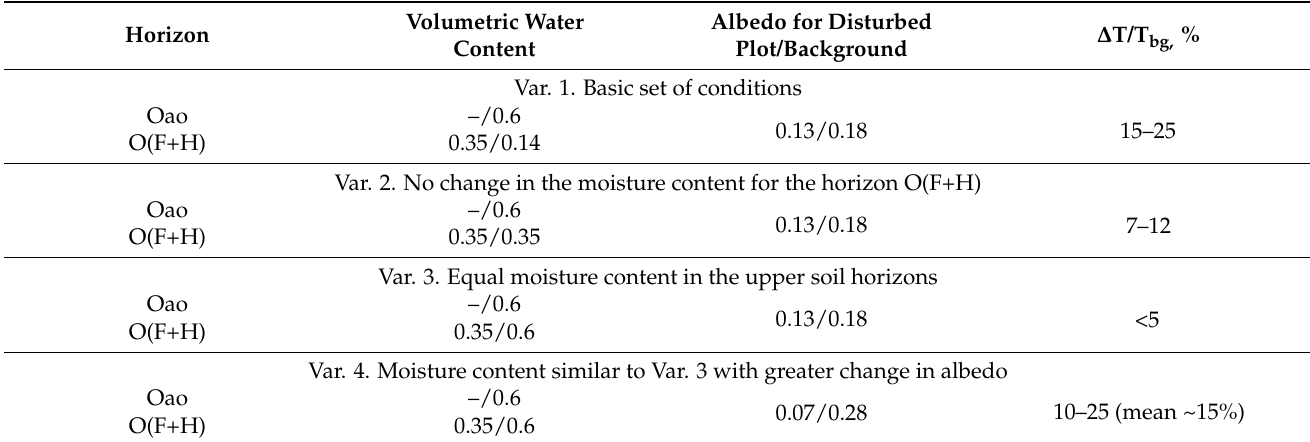
Figure 4. Results of numerical simulation of the heat transfer in soils: ( a ) temperature at the depth of 0.1 m, ( b ) the vertical coordinate of the phase change boundary, ( c ) relative temperature anomaly at the soil surface during summer ∆ T/T bg , ◦ C/ ◦ C (%), and ( d ) annual cycle of the total heat flux on the damaged soil surface (W/m 2 ). Table 5. Moisture content and albedo in the variants of model problem statement and calculated values of ∆ T/T bg for summer. Moisture content and albedo are given for disturbed/non-disturbed